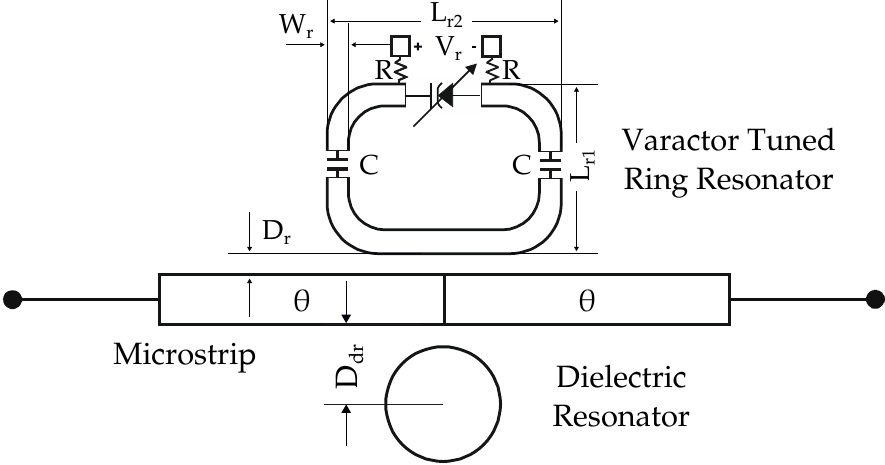
Figure 1. Schematic structure of the electronically tuneable DR band-stop filter, along with its main geometric